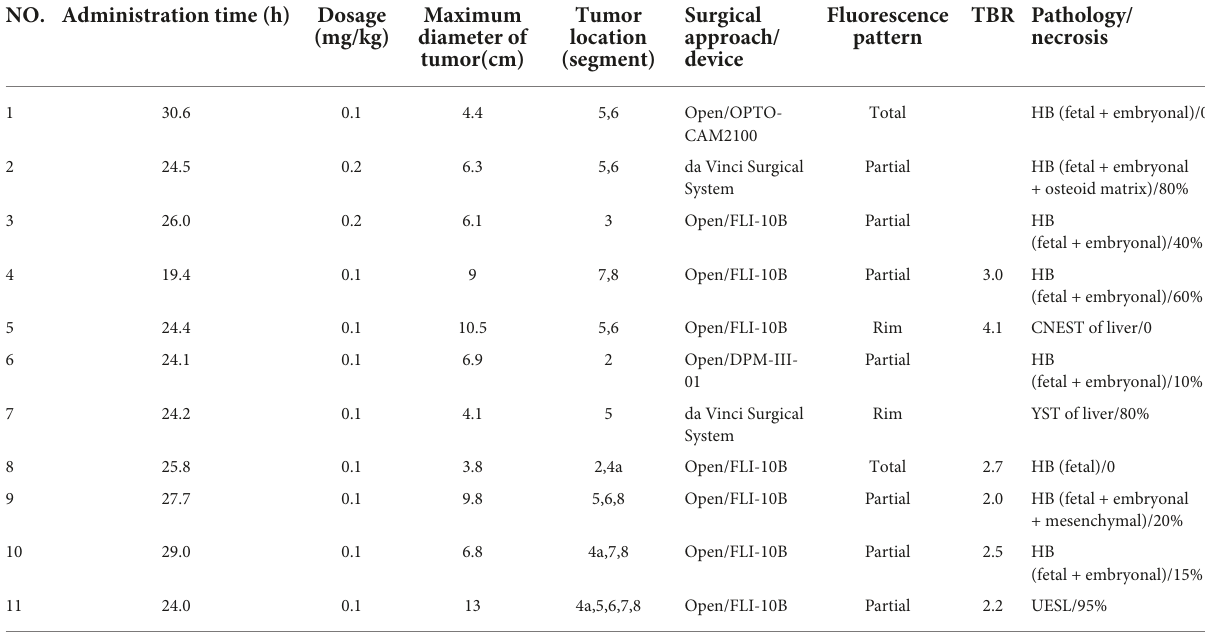
TABLE 2 Information of ICG navigation surgery in 11 cases with liver